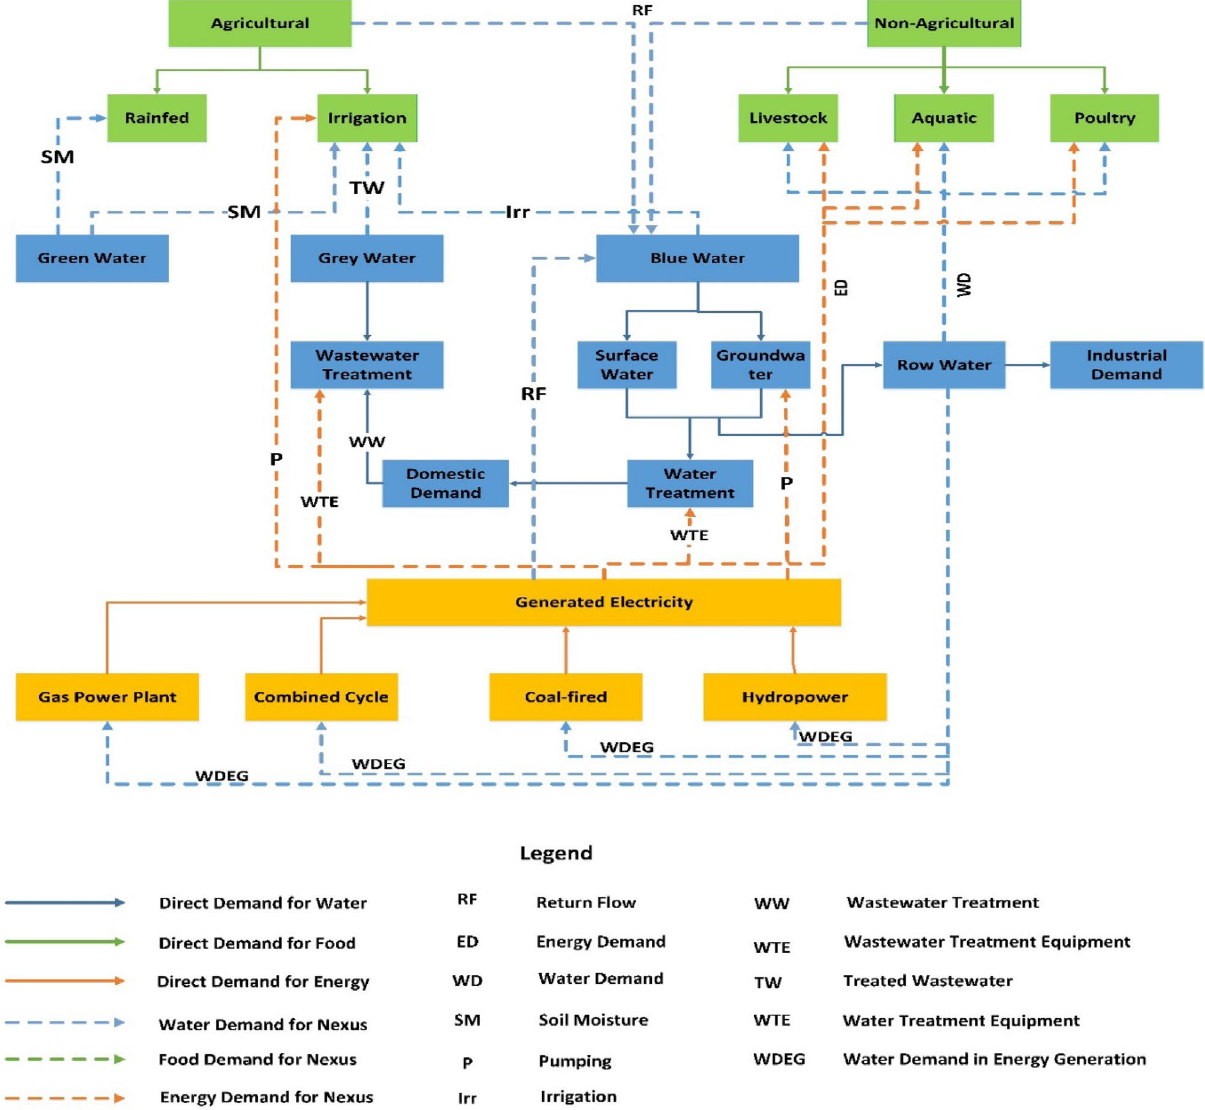
Figure 1. The WEF resources nexus interactions 18,31